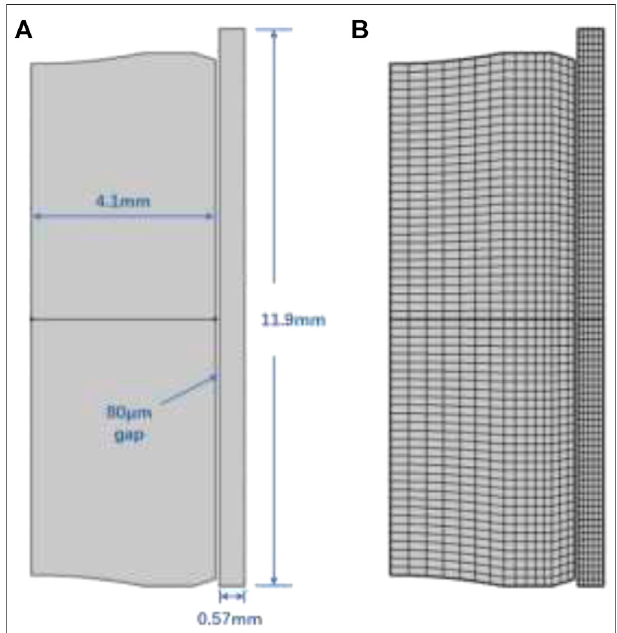
FIGURE 1 | (A) Geometry of 2D-axisymmetric, (B) pellet geometry with mapped mesh.